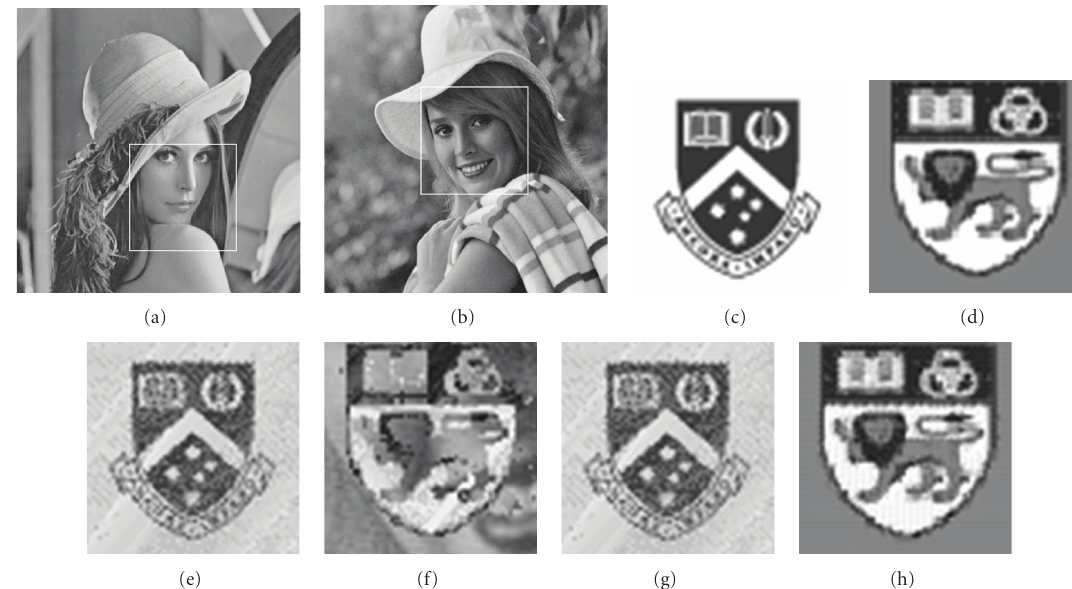
Figure 3: Original images (a) Lena and (b) Elaine with their ROIs used; original logos (c) Monash and (d) NUS; mapped logos by TROI- based scheme [12] (e) Monash (15.19 dB, 53%) and (f) NUS (17.47 dB, 55%); and coded logos by VQ-based scheme [13] (g) Monash (23.40 dB, 64%) and (h) NUS (25.35 dB, 66%). Note that all images (512 × 512) and logos (64 × 64) are 8-bit gray-scale. Request granted to use logos for research purposes only.